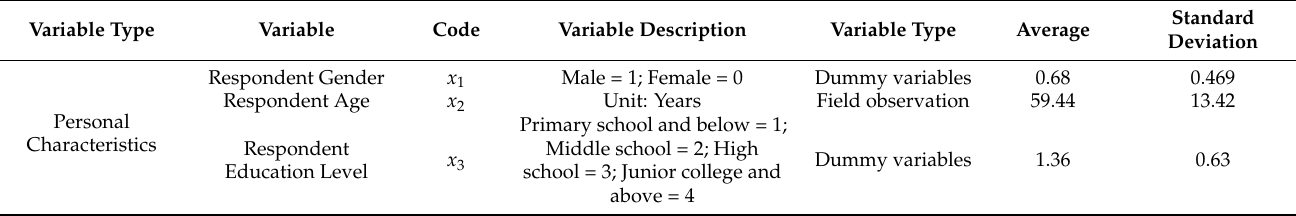
Table 3. Index system and statistical